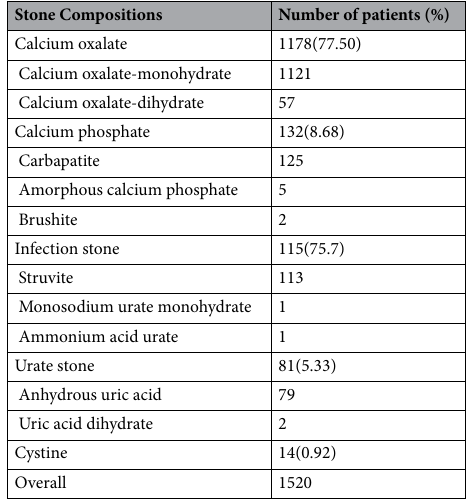
Table 3. The distribution of main urinary stone composition.